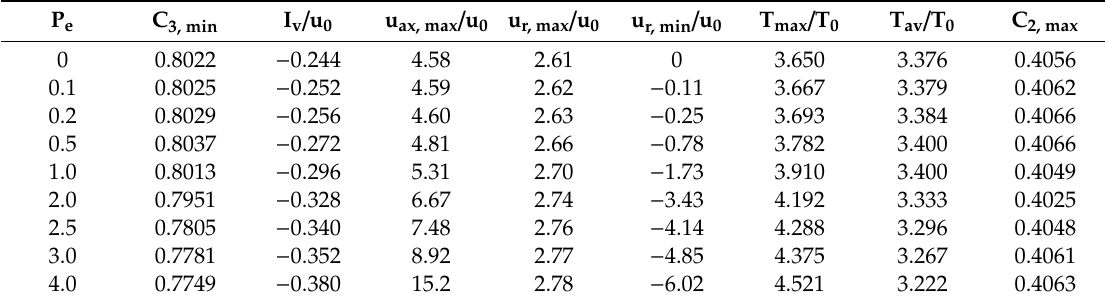
Table 2. The flame flow parameters: axial velocity (u ax, max ), radial velocity (u r, max ), temperature (T max ), mass fraction of intermediate products (C 2, max ), radial velocity (u r, min ), mass fraction of final products (C 3, min ), vorticity intensity (I v ) and radially-averaged flow temperature (T av ), depending on the electromagnetic parameter P e for the flow swirl number S = 3.